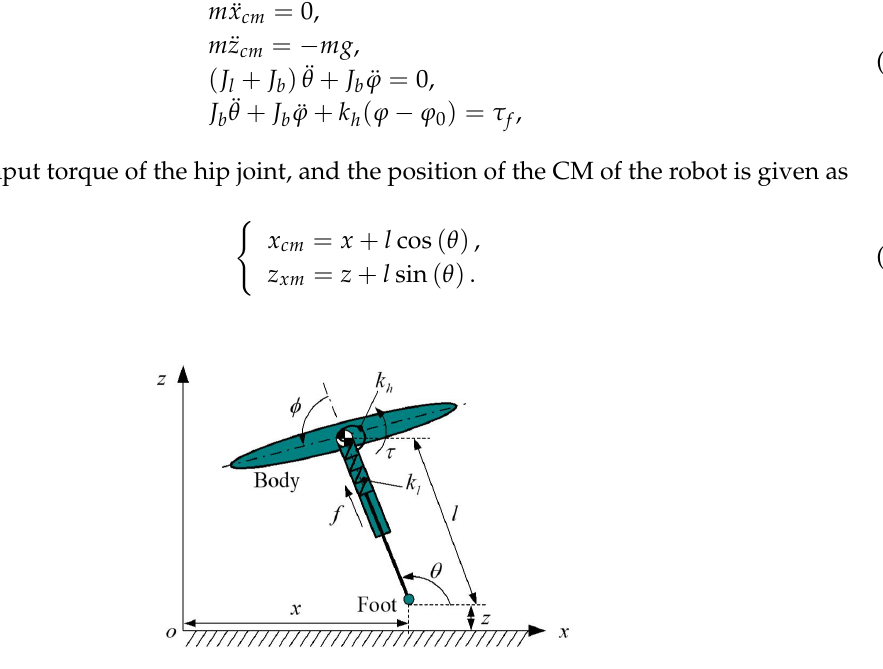
Figure 1. Model of a planar one-legged hopping